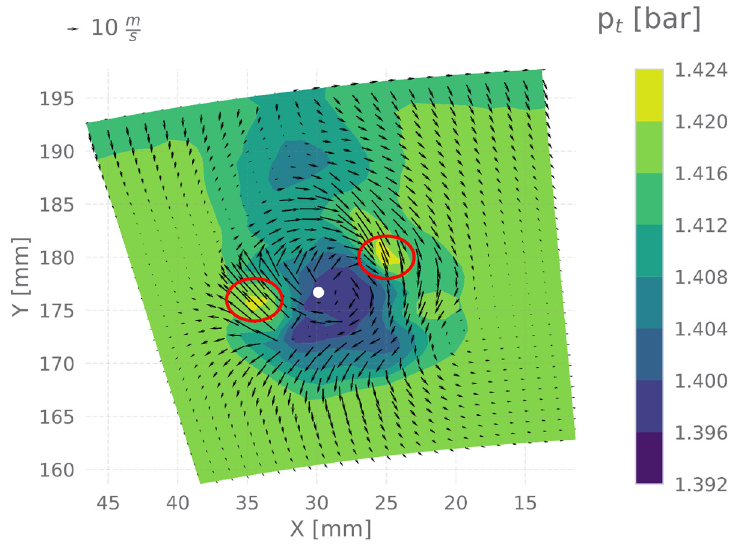
Figure 18. Turbine aerodynamic flow field, stator inlet. Red circles represent the EWG hot–cold jets, the white point is the center of the vortex.